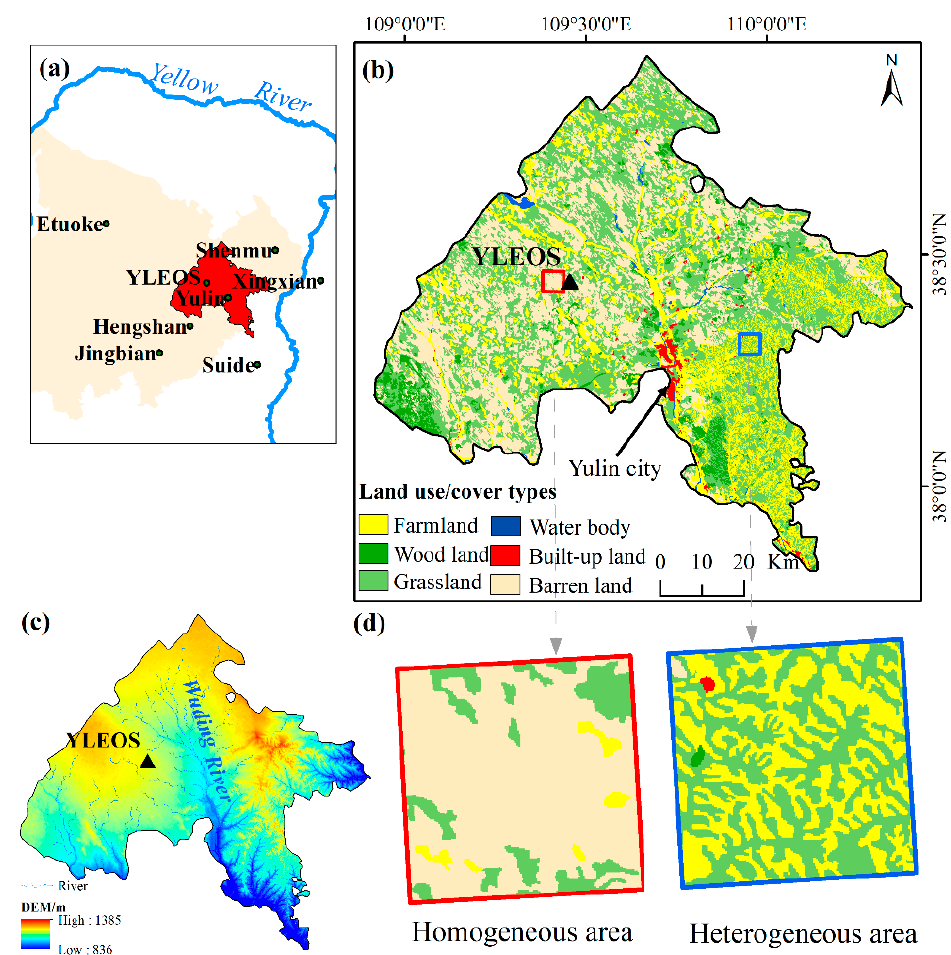
Figure 1. Map of the study area: ( a ) location of the study area (the Yuyang District) in the agro- pastoral ecotone, Northwestern China and locations of meteorological stations; ( b ) land use/cover map of the study area and location of the homogeneous and heterogeneous area and flux tower site; ( c ) DEM and water network; ( d ) characteristics of the homogeneous and heterogeneous areas. YLEOS refers to the Yulin Ecohydrological Observation Station, Tsinghua University.